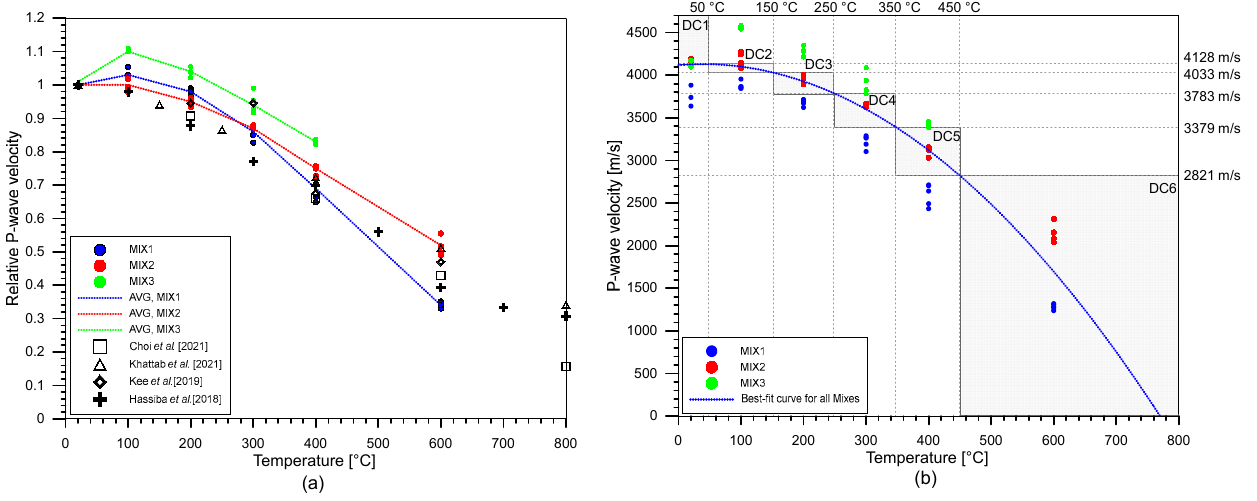
(cid:16) V (cid:17) (cid:3023) (cid:3291)(cid:3269) pT (cid:3440) from the experimental data of this study from the experimental data of this study V P20 (cid:3023) (cid:3265)(cid:3118)(cid:3116)